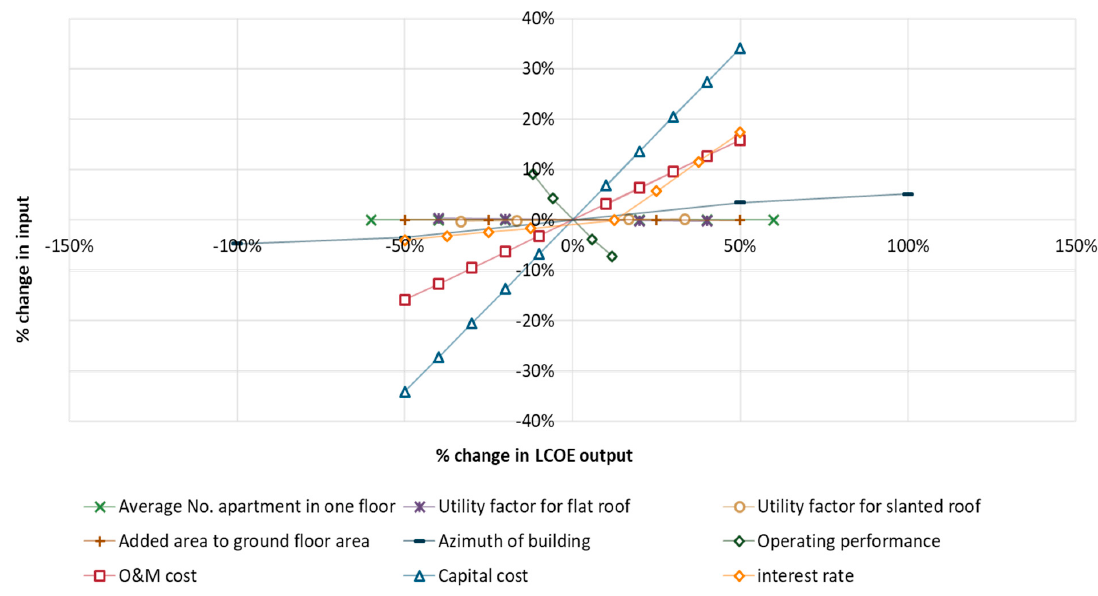
Figure 9. Sensitivity analysis of input variation effect on LCOE output.